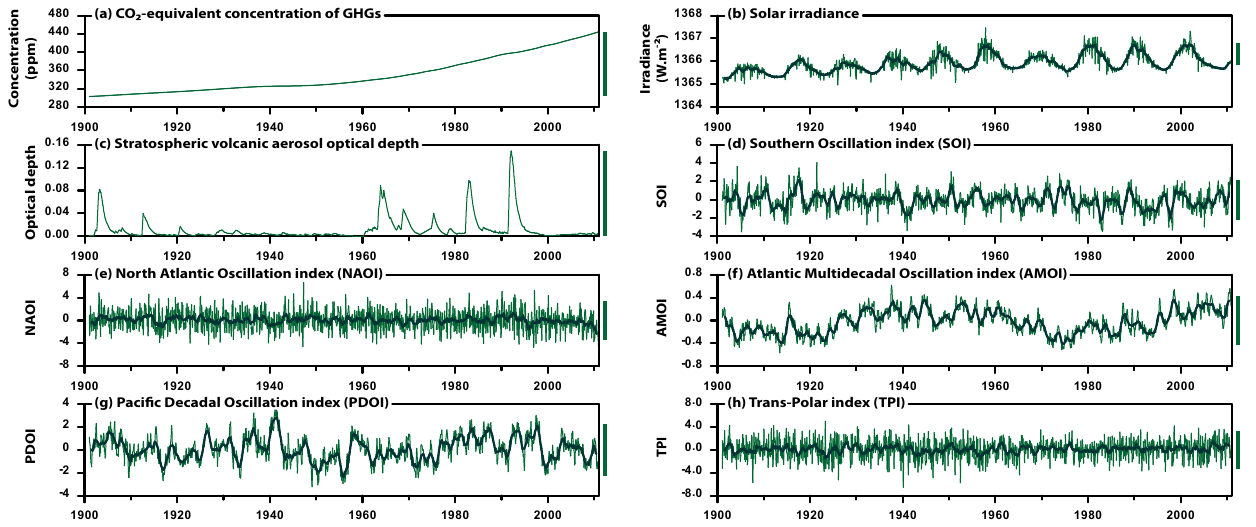
Figure 1. Time series of the explanatory variables employed in the attribution analysis. Bars to the right of individual panels illustrate the pre-selected characteristic variations of the predictors, used for calculation of the temperature responses: increase of CO 2 -equivalent GHG concentration between 1901 and 2010 ( + 141ppm); increase of solar irradiance by 1Wm − 2 ; Mt. Pinatubo-sized volcanic eruption (aerosol optical depth + 0.15); increase of SOI, NAOI, AMOI, PDOI and TPI by four times the standard deviation of the respective time series. Thicker, darker lines represent a 13-month moving average of the